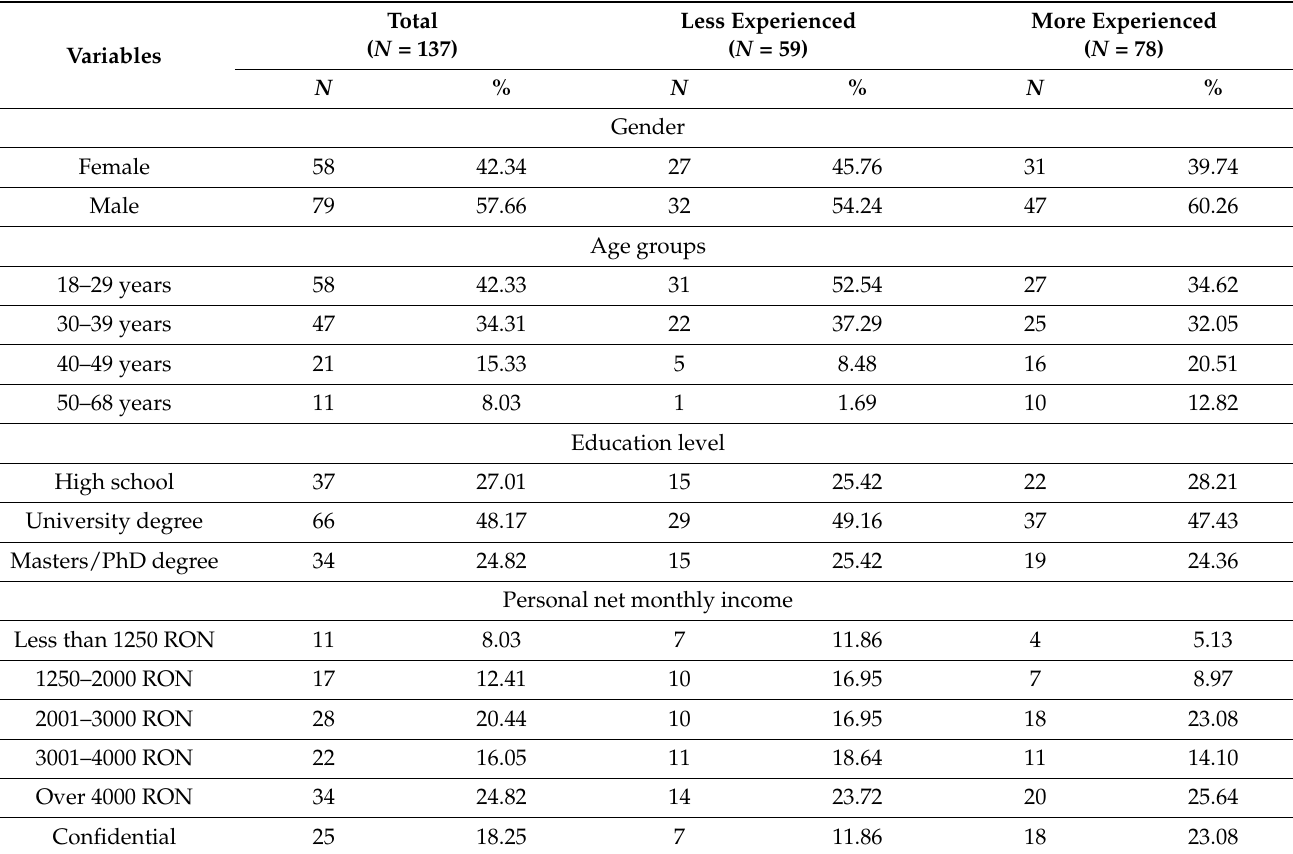
Table 1. Sociodemographic characteristics of